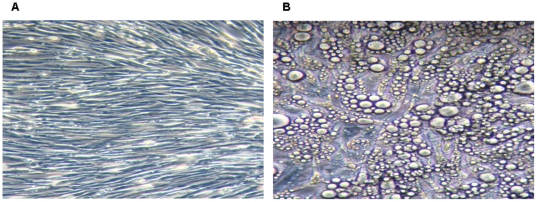
Differentiation of human pre-adipocytes into adipocytes.Panel A shows human pre-adipocytes (long, thin and flatted cells without detectable fat organelles). Panel B shows that differentiated fat cells (adipocytes) are spherical with differences in fat organelle size. Most space in adipocytes is occupied by fat organelles.